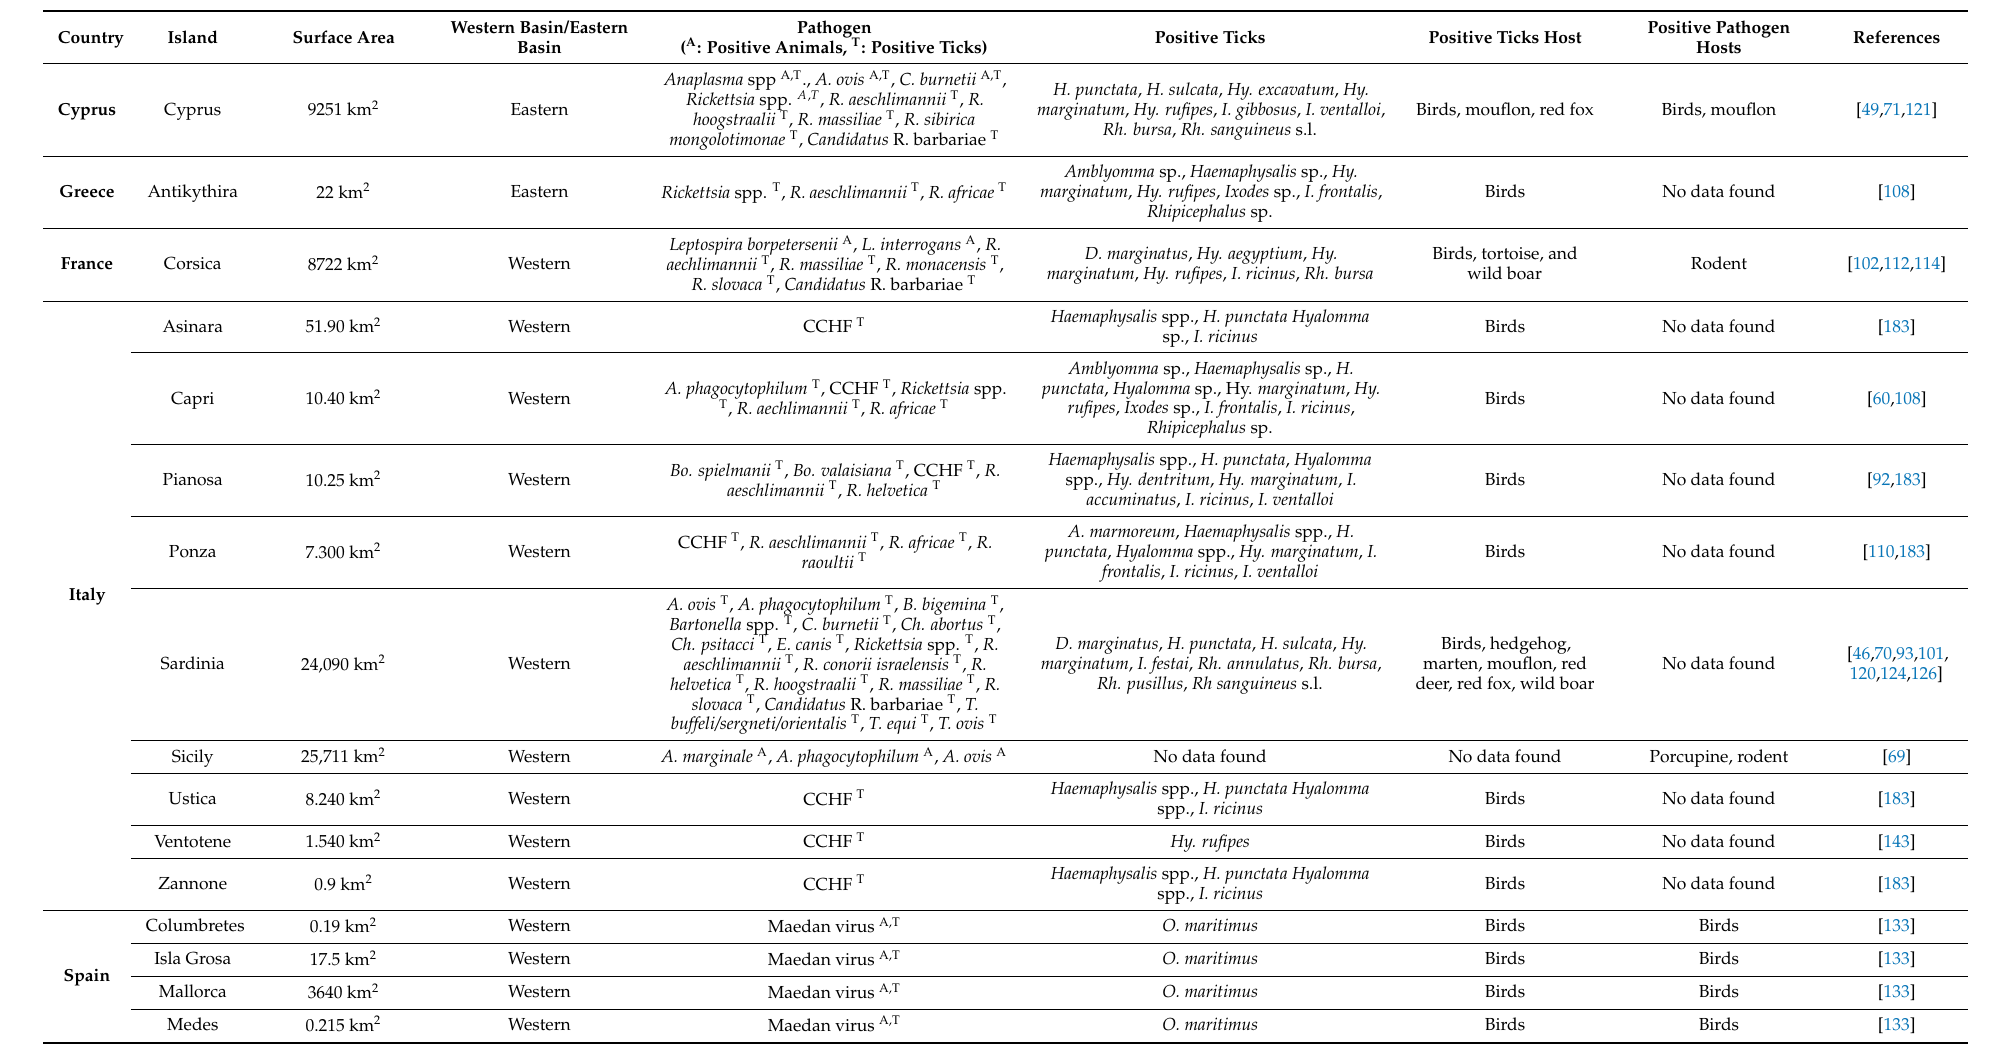
Table 3. Ticks and tick-borne pathogens from wild animals on Mediterranean